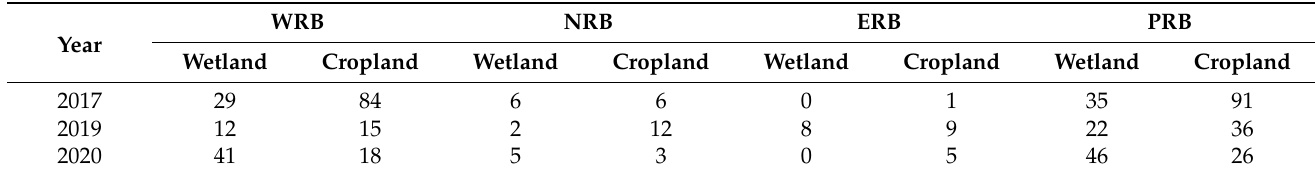
Table 4. Number of flood locations identified from wetlands and croplands in 2017, 2019 and 2020.